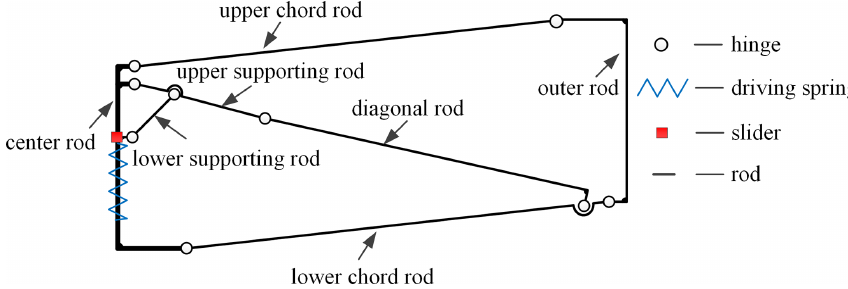
Figure 2. Diagram of basic rib